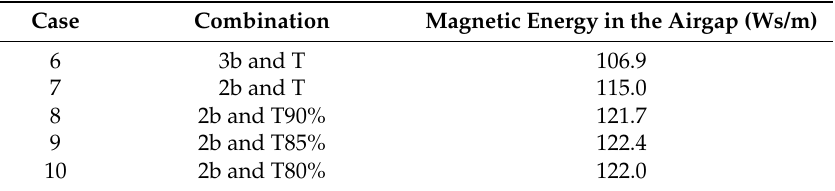
Table 7. Magnetic energy in the airgap for divided ferrites and different shapes of pole shoes.